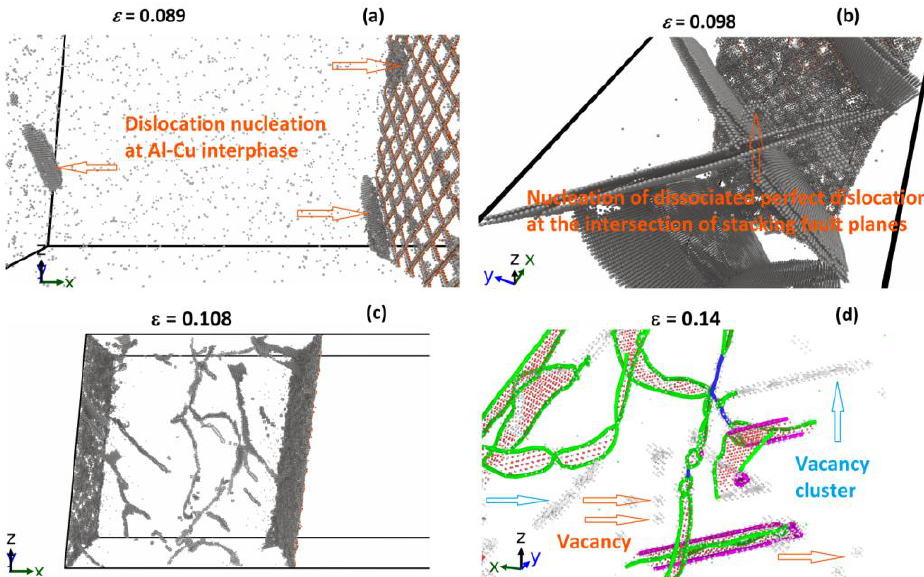
Figure 4. Development of plastic deformation in the aluminum part of the bisystem at initial pressure of 0 GPa; the following stages are shown: ( a ) the nucleation and emission of dislocations from the interface between materials; ( b ) the appearance of secondary dislocation half-loops consisting of leading and trailing partial dislocations; ( c ) the development of a dislocation network; ( d ) the active formation of vacancies. Only atoms with a high value of the centrosymmetry parameter are shown. Aluminum atoms are grey colored, copper atoms are orange colored. The corresponding values of engineering strain 𝜀 are indicated in the figure.